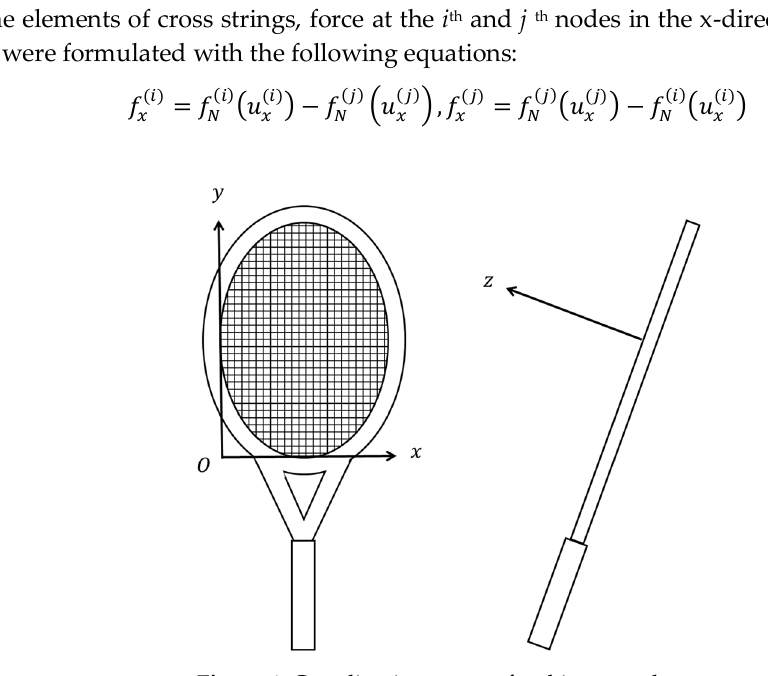
Figure 1. Coordination system for this